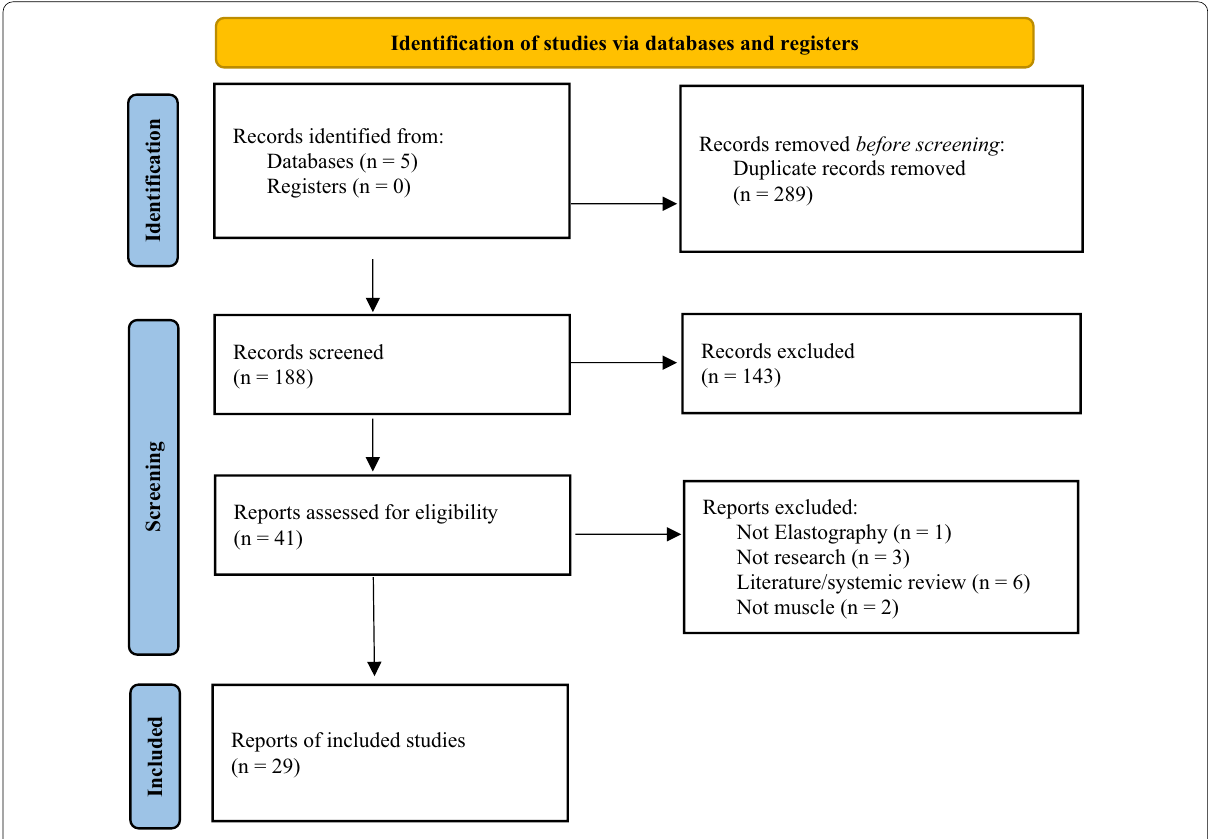
Fig. 1 PRISMA flowchart for the identification of